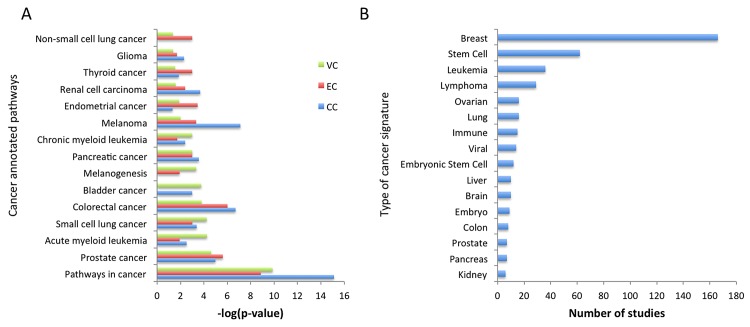
Cancer-related pathways and signatures enriched in gynecological cancers.A. Bar graphs showing the significance of overlap between the three gynecological cancers in this study with other known types of cancers and their annotated pathways. B. Oncogenic gene signatures from MSigDB 4.0 [14] and GeneSigDB 4.0 [15].